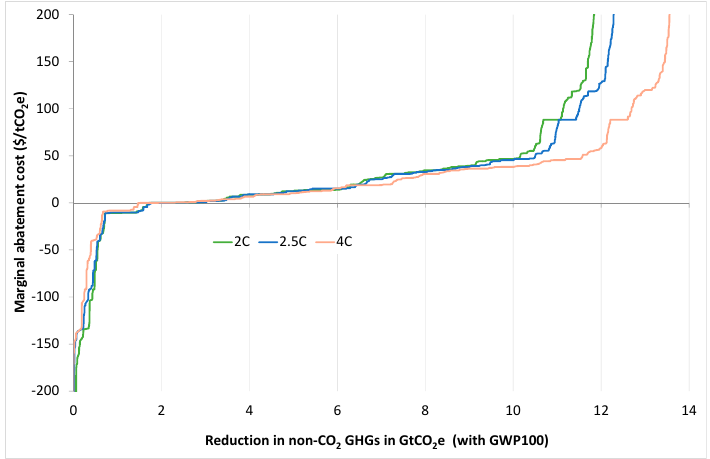
Figure 6. Global marginal abatement cost curves in 2050 for the total non-CO 2 GHGs (GWP100 basis) for different LTTGs, relative to the case where indirect non-CO 2 GHG mitigation resulting from CO 2 mitigation has already occurred. Notes: Measures with a negative marginal abatement cost are assumed to be cost-saving if adopted. They are not assumed to be taken up in the reference scenario, as a result of uncertainty, inertia and inefficiency in current